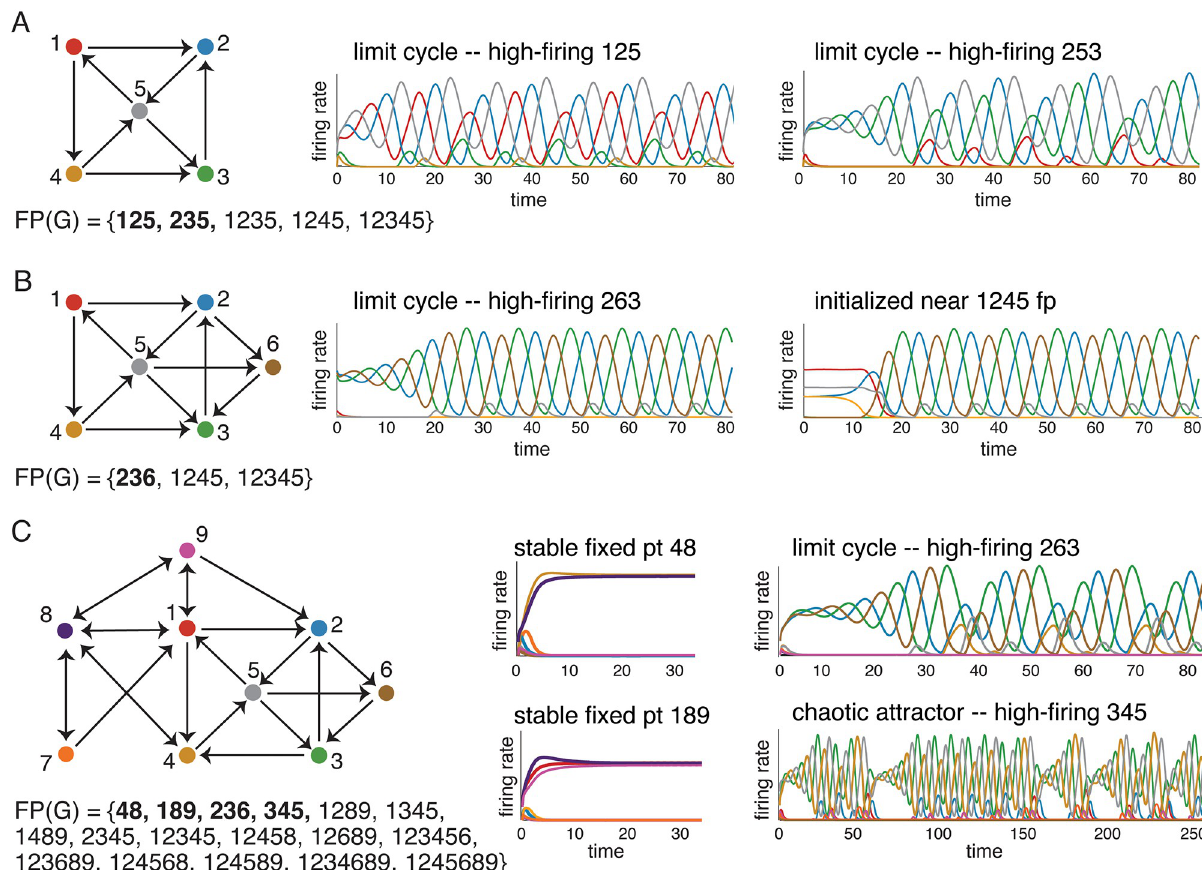
Fig 4. Correspondence between core fixed points and attractors. For each of the three graphs, FP( G ) was computed using graph rules. Minimal fixed points that are also core fixed points are shown in bold. (A) A network on five nodes with two core fixed points supported on 125 and 235. Each of the two attractors of the network can be obtained via an initial condition that is a perturbation of one of these fixed points. The first attractor follows the cycle 125 in the graph, while the second one follows the cycle 253. (B) A network with the same graph as in A, except for the addition of node 6. Although there are two minimal fixed points, supported on 236 and 1245, only the fixed point for 236 is core and yields an attractor. Initial conditions near the 1245 fixed point (denoted 1245 fp) produce solutions that stay near the (unstable) fixed point for some time, but eventually converge to the same 236 attractor. (C) A larger network built by adding nodes 7, 8, and 9 to the graph in B, and flipping the 4 ! 3 edge. This CTLN has four core fixed points, and no other minimal fixed points. Each core fixed point has a corresponding attractor: stable fixed points supported on 48 and 189, a limit cycle supported on 236, and a chaotic attractor for